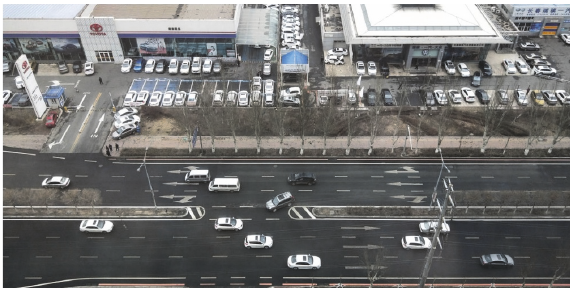
Figure 3: Scene of the U-turn point in Changchun,